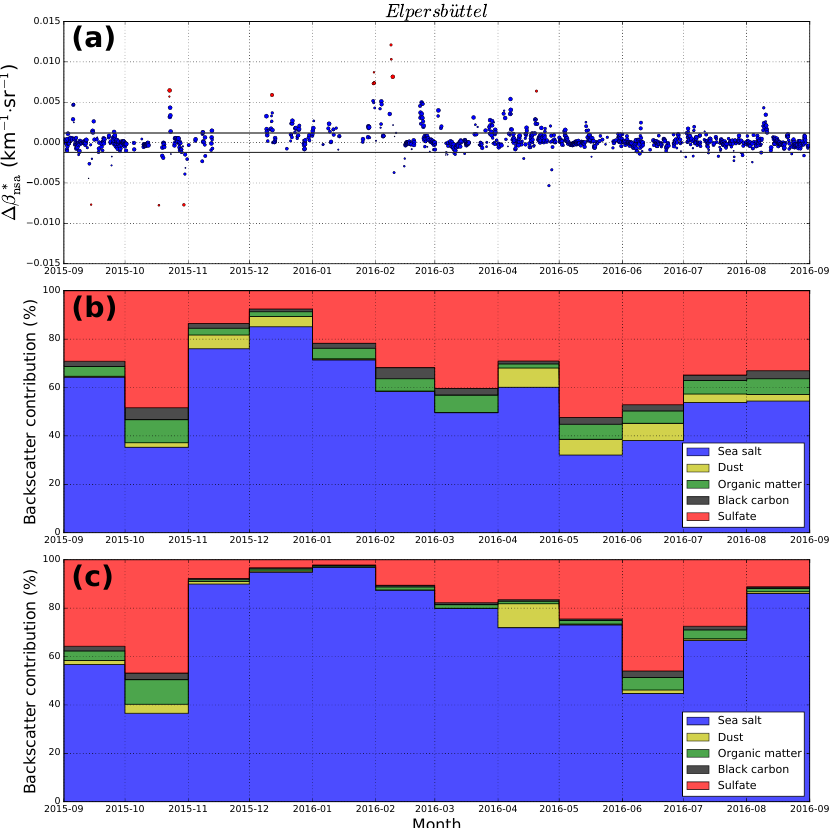
Figure 4. (a) Differences ( (cid:49) ) of near-surface attenuated backscatter β ∗ ns for Elpersbüttel according to Eq. (14). The horizontal line indicates the standard deviation ( σ ) of the differences. The size of the markers represents the number of ceilometer measurements available for each individual comparison. Differences | (cid:49) | > 3 σ are shown in red. (b) Contribution of different aerosol types to β ∗ ns for cases with | (cid:49) | < σ . (c) Same as panel (b) but for cases with | (cid:49) | > σ